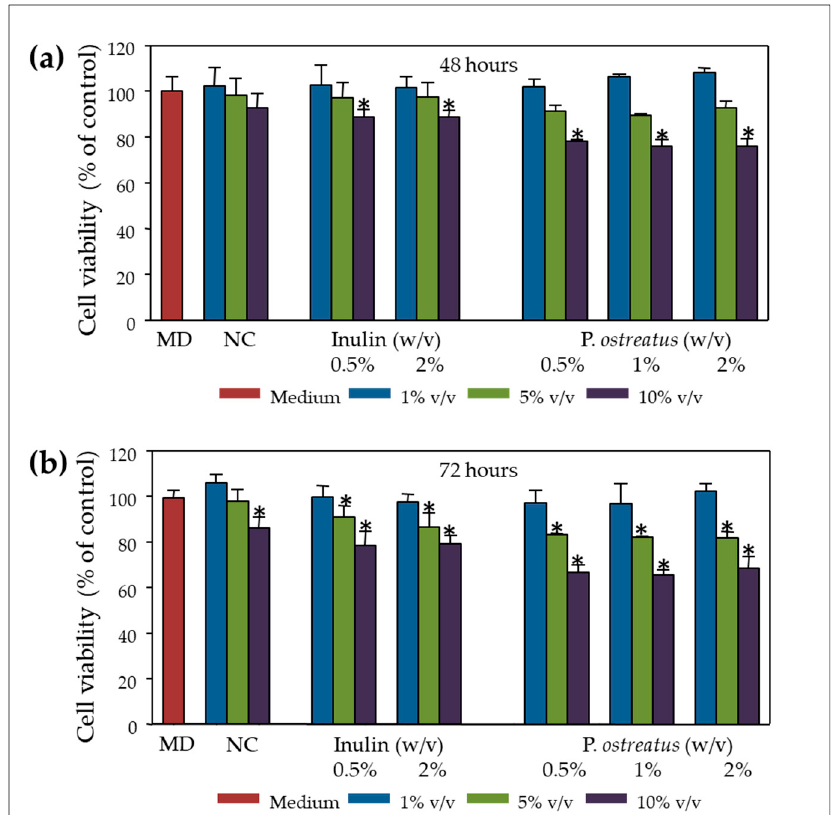
Figure 2. Inhibition of cell proliferation by post-fermentation supernatants (FSs): FSs with different concentrations of the prebiotic inulin (0.5% w/v and 2% w/v ) and lyophilized P. ostreatus 1123 powder (0.5% w/v , 1% w/v and 2% w/v ), fermented by fecal inocula from one healthy donor were incubated with Caco-2 cells at 1%, 5% and 10% v/v for 48 ( a ) and 72 h ( b ) . Cells treated with medium only (MD) served as control. NC: basal medium with no additional carbohydrate source. All values are expressed as the mean ± standard deviation (SD) of at least two independent experiments. * p < 0.05 versus control/non-treated cells. Associations were not significant unless otherwise indicated.